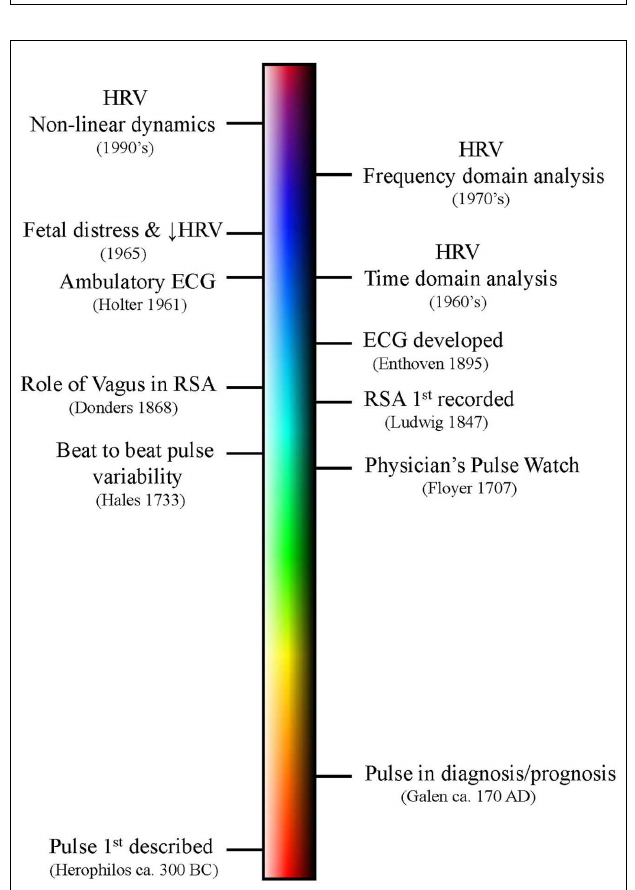
FIGURE 1 | Heart rate variability: representative electrocardiogram (ECG) recordings from a conscious dog that illustrate beat-to-beat variations in both R–R interval and heart rate.